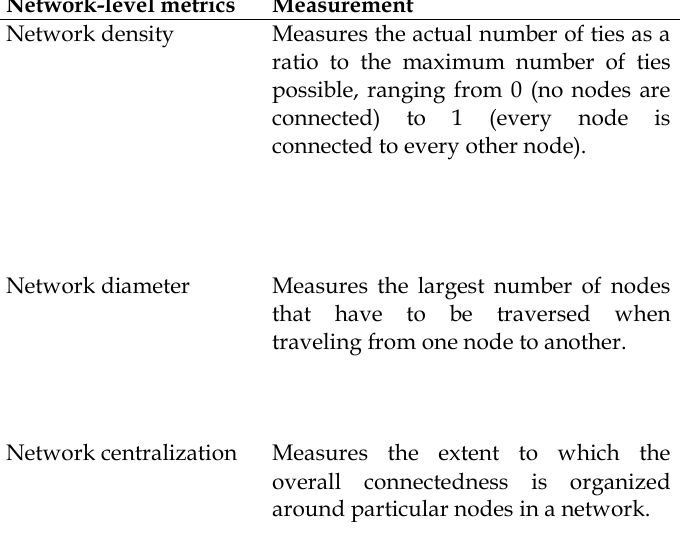
Table 3. Network-level metrics and their conceptual definition Network-level